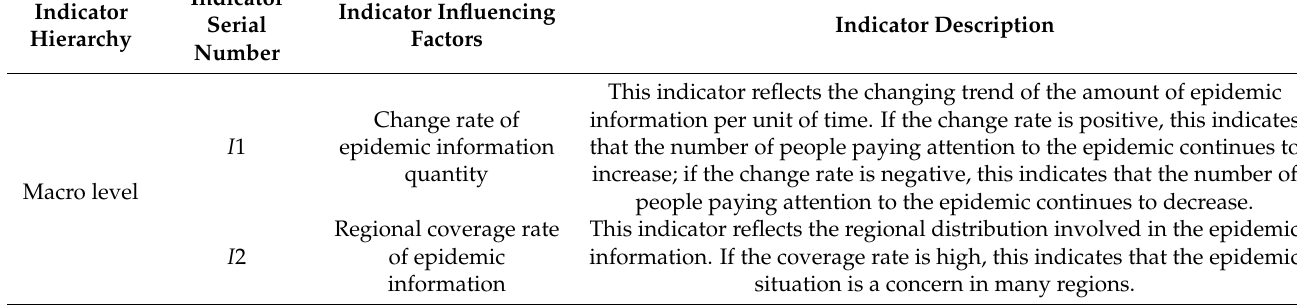
Table 2. Early warning indicator system of epidemic information public